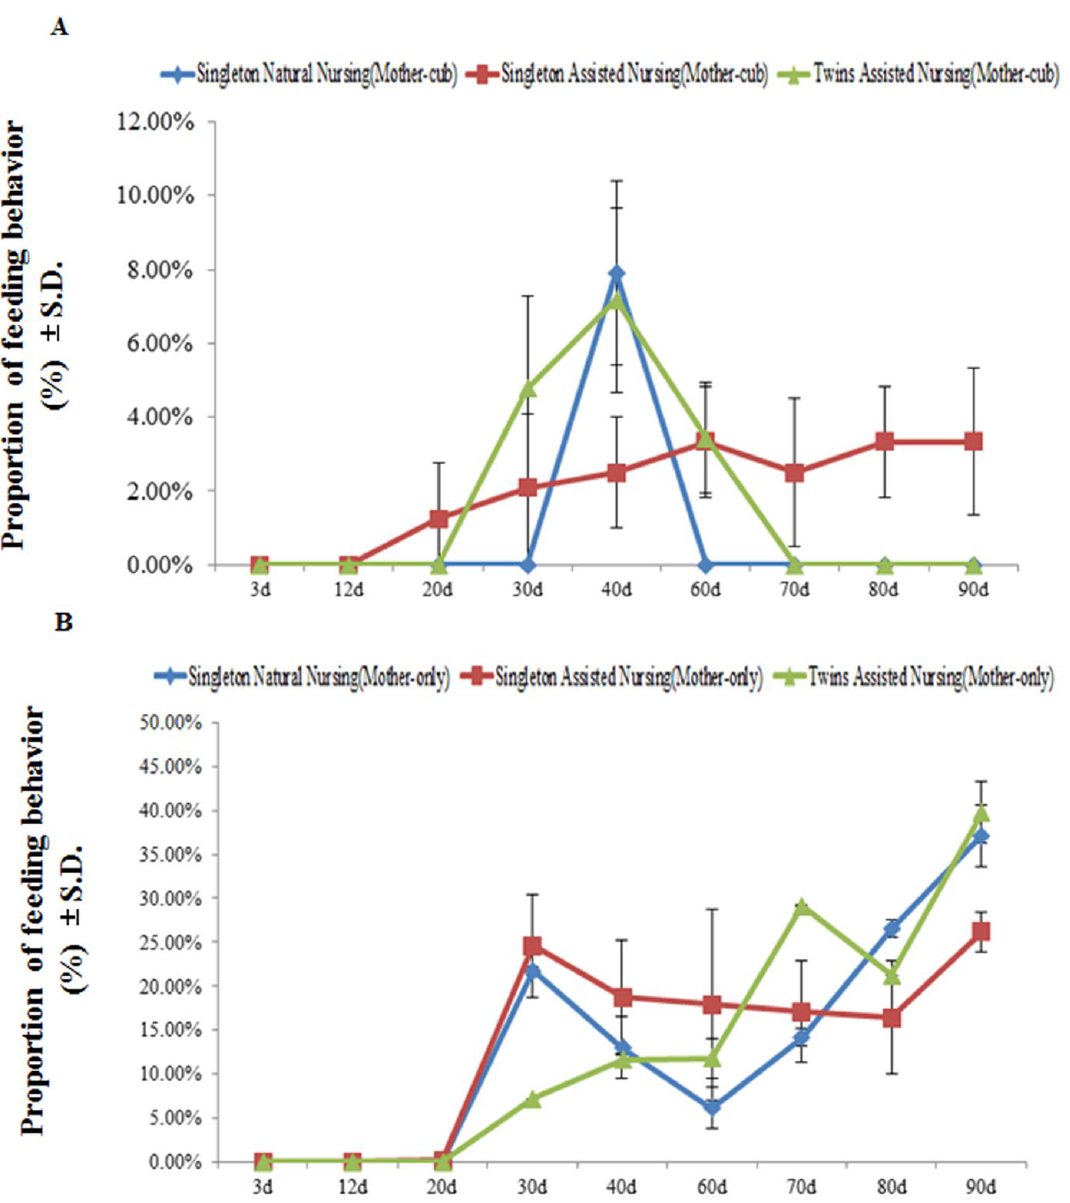
Figure 3. The percentage of time engaged in mother feeding behavior during the mother–cub (panel A ) period and mother-only period (panel B ). Data were presented as the mean ± S.D. (standard deviation). n = 3 per group.